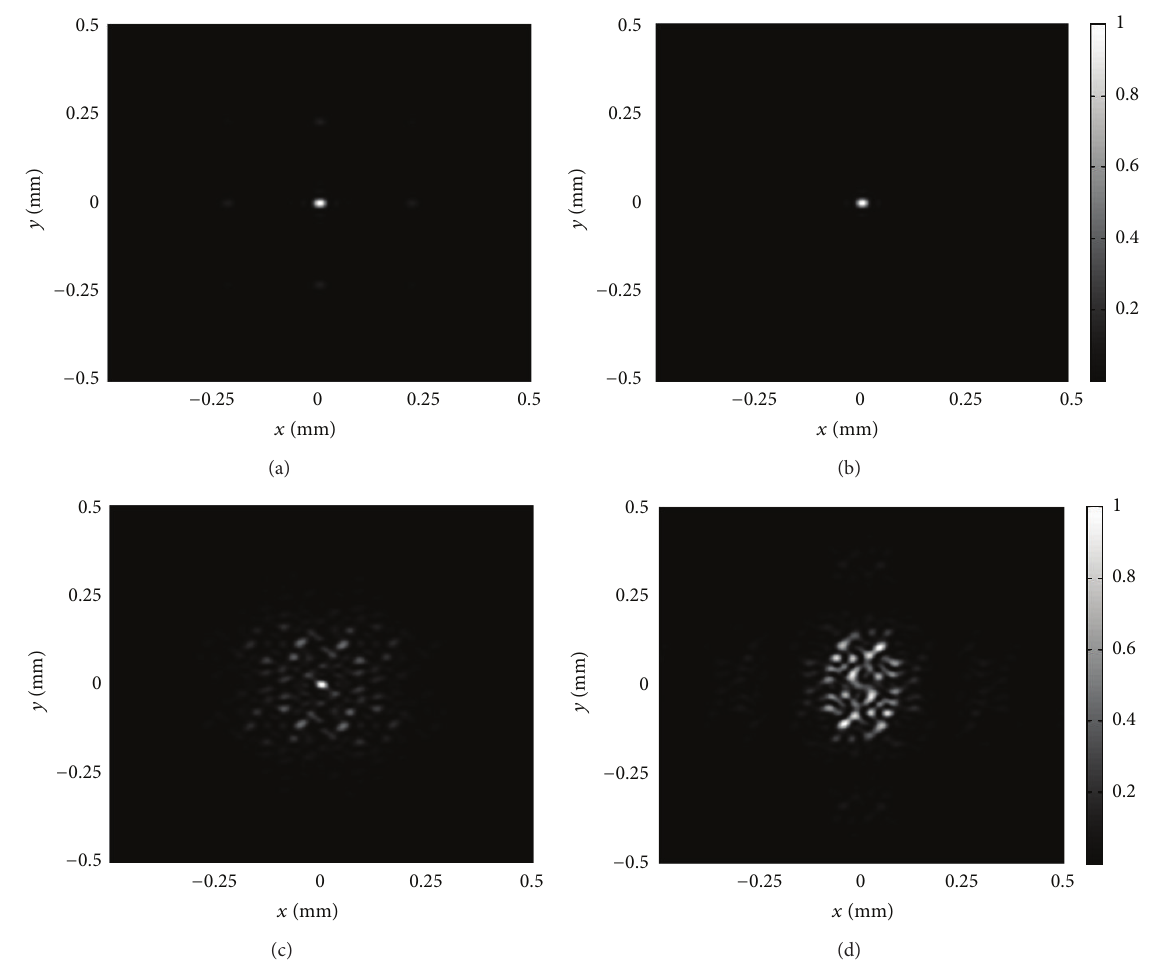
Figure4: Farfield diffractionpatternsat adistanceof1mof (a)binaryimagedepicted inFigure 2(a); (b)binary imagedepicted in Figure 2(b); (c) hybrid ternary image depicted in Figure 3(a); and (d) hybrid ternary image depicted in Figure